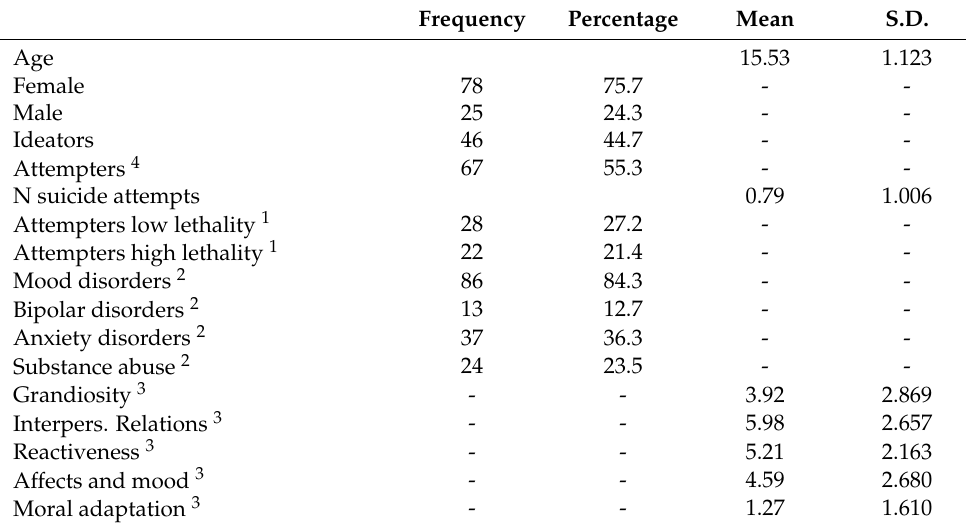
Table 1. Descriptive analysis of the sample.